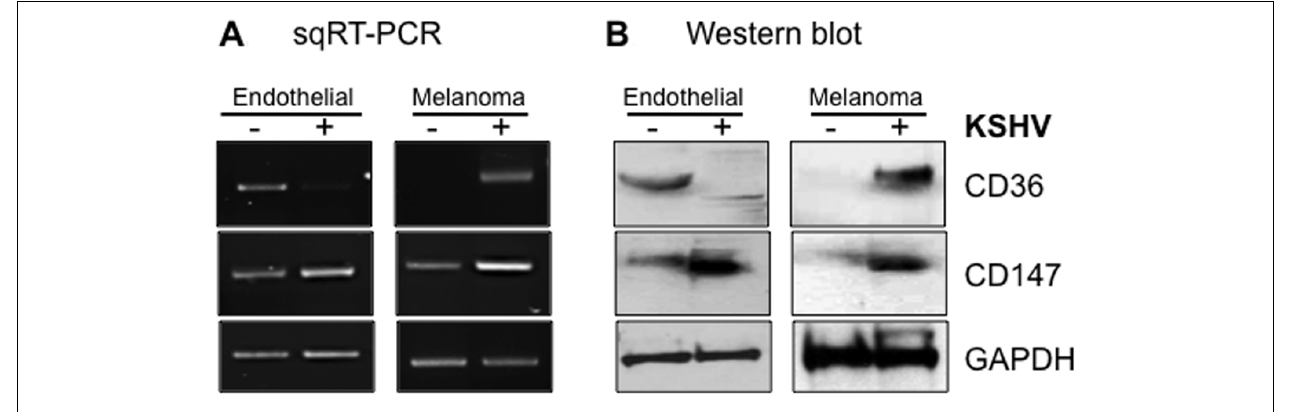
telomerase-immortalized mixed dermal microvascular and brain endothelial cells, KSHV upregulates CD147 (confirming a recent study; Qin etal., 2010) but downregulates expression of CD36 (and its angiostatic ligand,TSP-1; data not shown); in vivo , these dichotomous effects are consistent with promotion of angiogenesis, invasion, and tumor metastasis in disease-relevant cell